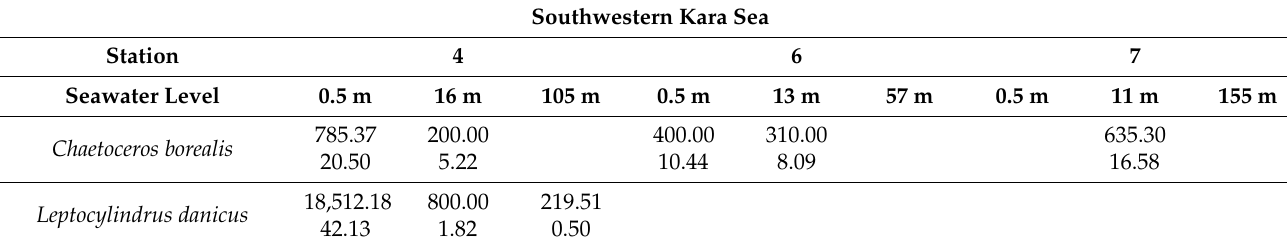
Table A1. Abundance (thousand cells/L, numbers above the lines) and biomass ( µ g/L, numbers below the lines) of dominant phytoplankton species (reaching more than 10% of the abundance or biomass in samples) in the water areas under